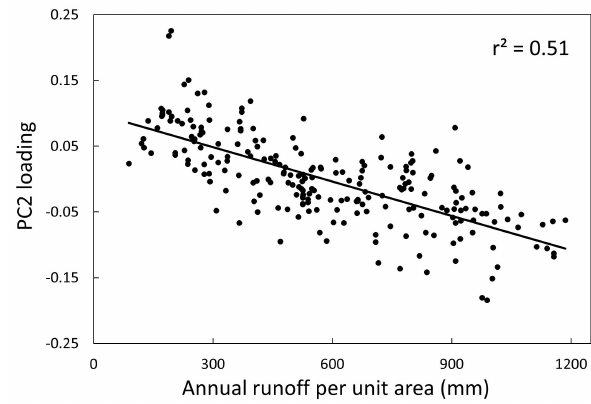
Figure 8. Plot of S-mode eigenvector loadings from 226 stream sites on PC1 and PC2. Note that the range of variation in the PC1 loadings is small relative to the loadings along PC2, which indi- cates that most of the differences among sites were associated with the second principal component.